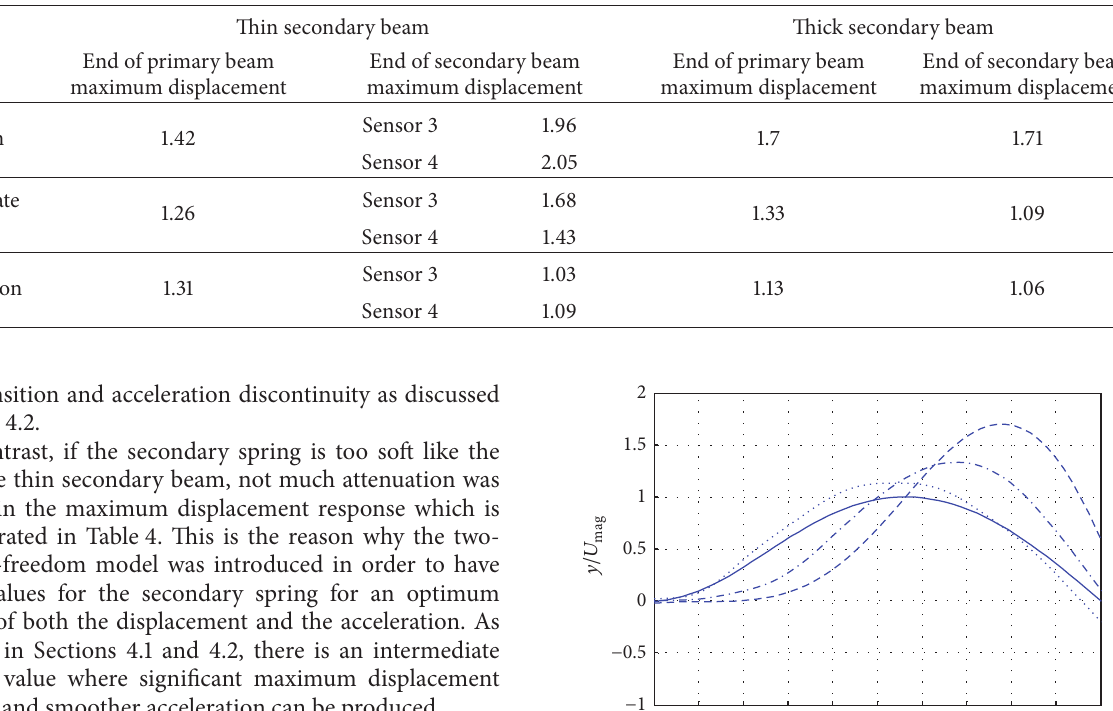
Table 4: Comparison between the maximum displacement responses of the systems with thin and thick secondary beams. The maximum displacement values are normalized with respect to the maximum base input displacement.